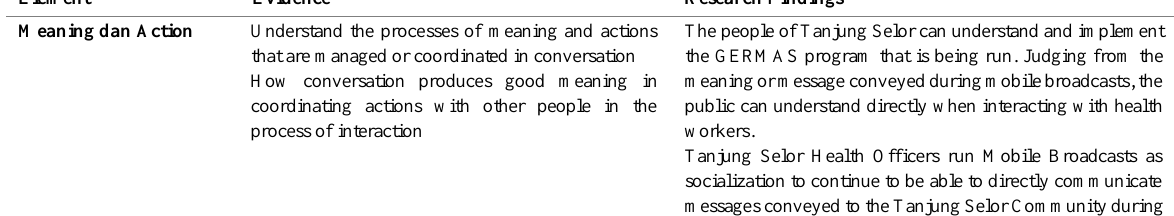
Table 2: Summary of